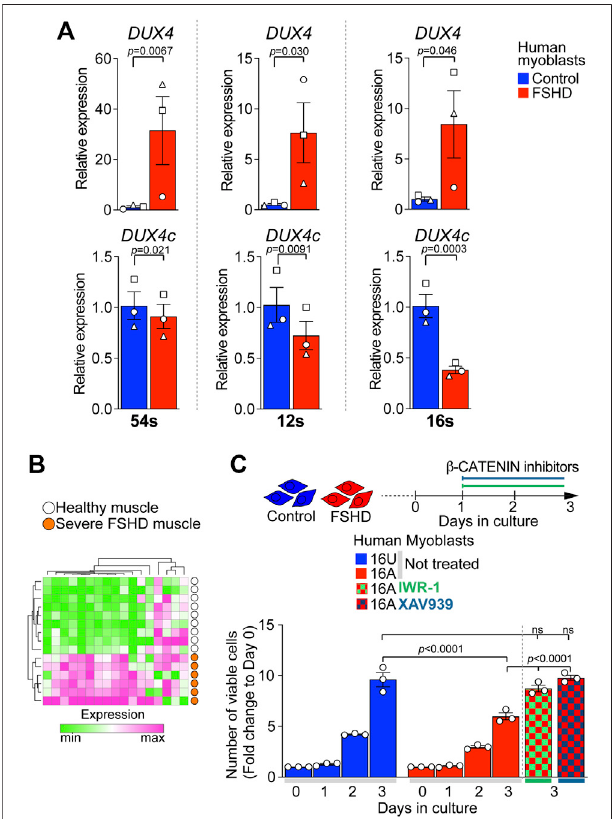
FIGURE6| ReducedDUX4cexpressioninFSHDmyoblastsandrescue of proliferation via β -CATENIN inhibition. (A) RT-qPCR analysis on the ‘ 54s ’ , ‘ 12s ’ , and ‘ 16s ’ patient-derived immortalised myoblast lines showing higher expression of DUX4 and lower expression of DUX4c in all FSHD clones (54-12, 12A, and 16A) compared to unaffected matched control cells (54-6, 12U, and 16U) N = 3 biological replicates, paired t-test, symbols indicate independent biological replicates within same cell line. (B) 17/88 of genes differentially expressed in opposite directions by DUX4 and DUX4c relate to WNT/ β -CATENIN signalling. A heatmap depicts that expression of this 17 gene subset separates human muscle biopsies of severe (Group 4) FSHD patients ( n = 6, orange) from healthy controls ( n = 9, white) from GSE115650 (Wang et al., 2019). (C) Cell viability assayed by counting number of cells over 3 days from plating indicates lower proliferation rate in 16A FSHD myoblasts compared to 16U controls. Notably, 48 h treatment with either IWR-1 (5 μ M) or ofXAV939(4 μ M)fullyrescues16Aproliferationtothelevel observedin16U control cells. Graphs report mean ± SEM from representative experiments with statistical signi fi cance between samples indicated by a